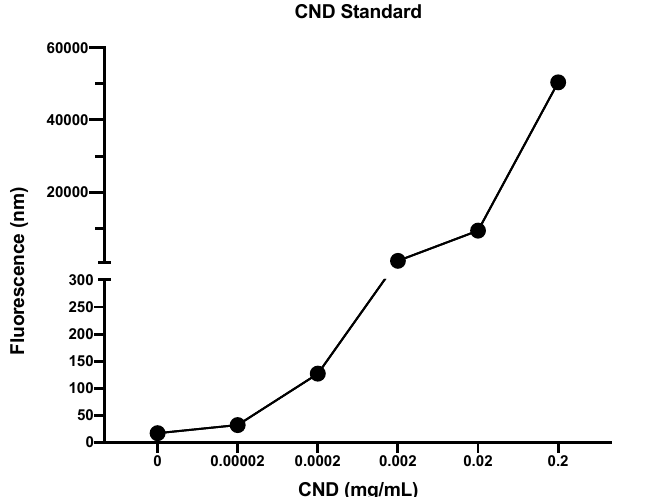
Figure 6. CND standard. A standard was created by completing a serial dilution of CNDS in di-water and then fluorescence was measured. Bio-Tek ® Synergy plate reader was used at 360/40 excitation and 460/40 emission.